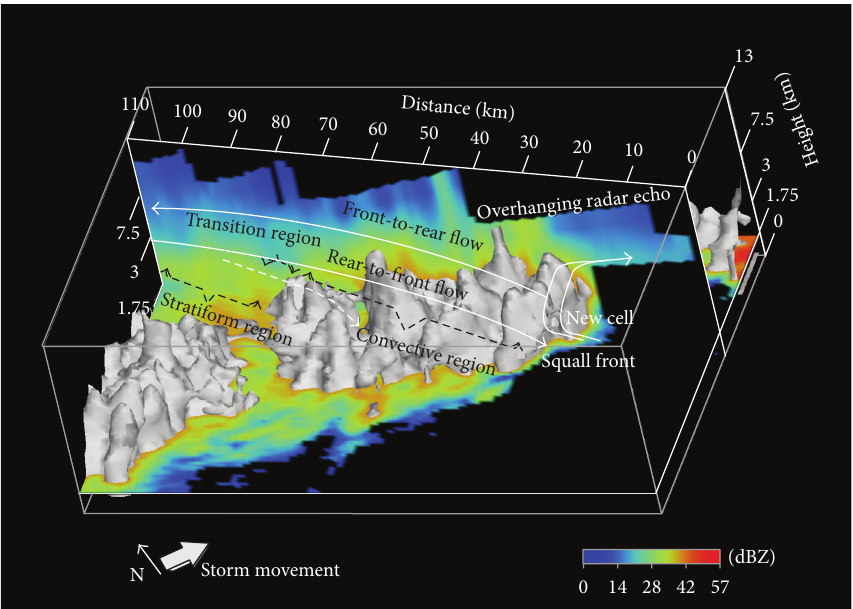
Figure 14: A 3D conceptual model of the squall line. White isosurfaces present the radar reflectivity of over 40dBZ. The horizontal colour shading presents the radar reflectivity at 1.75km. The vertical colour shading is the reflectivity in the vertical cross-section perpendicular to the squall line. The white thin solid arrows in the vertical cross-section are the storm-relative wind field. The arrow indicates the north (N). The 3D gray arrow presents the storm movement